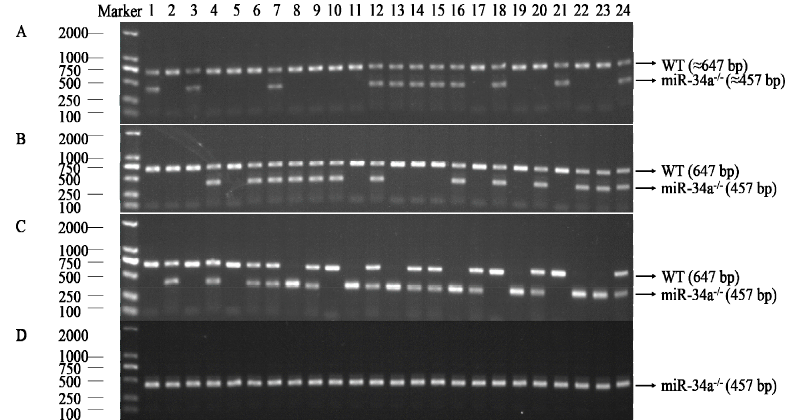
Figure 3. Establishment of miR-34a knockout zebrafish model. ( A ) Lanes 1–24: PCR products from F0 generation individuals; ( B ) Lanes 1–24: PCR products from F1 generation individuals; ( C ) Lanes 1–24: PCR products from F2 generation individuals; ( D ) Lanes 1–24: PCR products from F3 generation individuals.